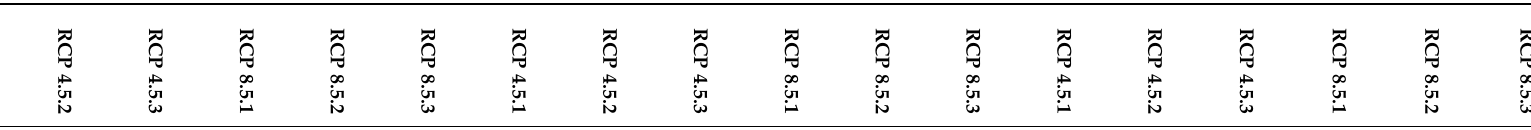
Table 6. Comparison of the average distribution of precipitation in individual months for the SWAT simulation period 2010–2017 with individual projections for